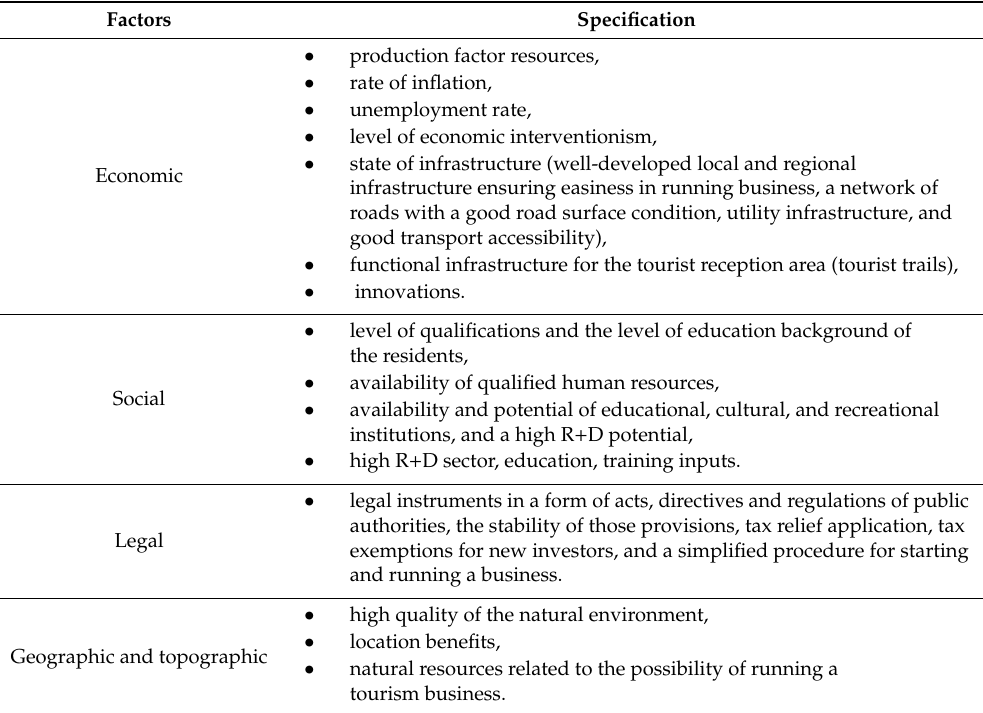
Table 1. Factors a ff ecting a region’s tourism